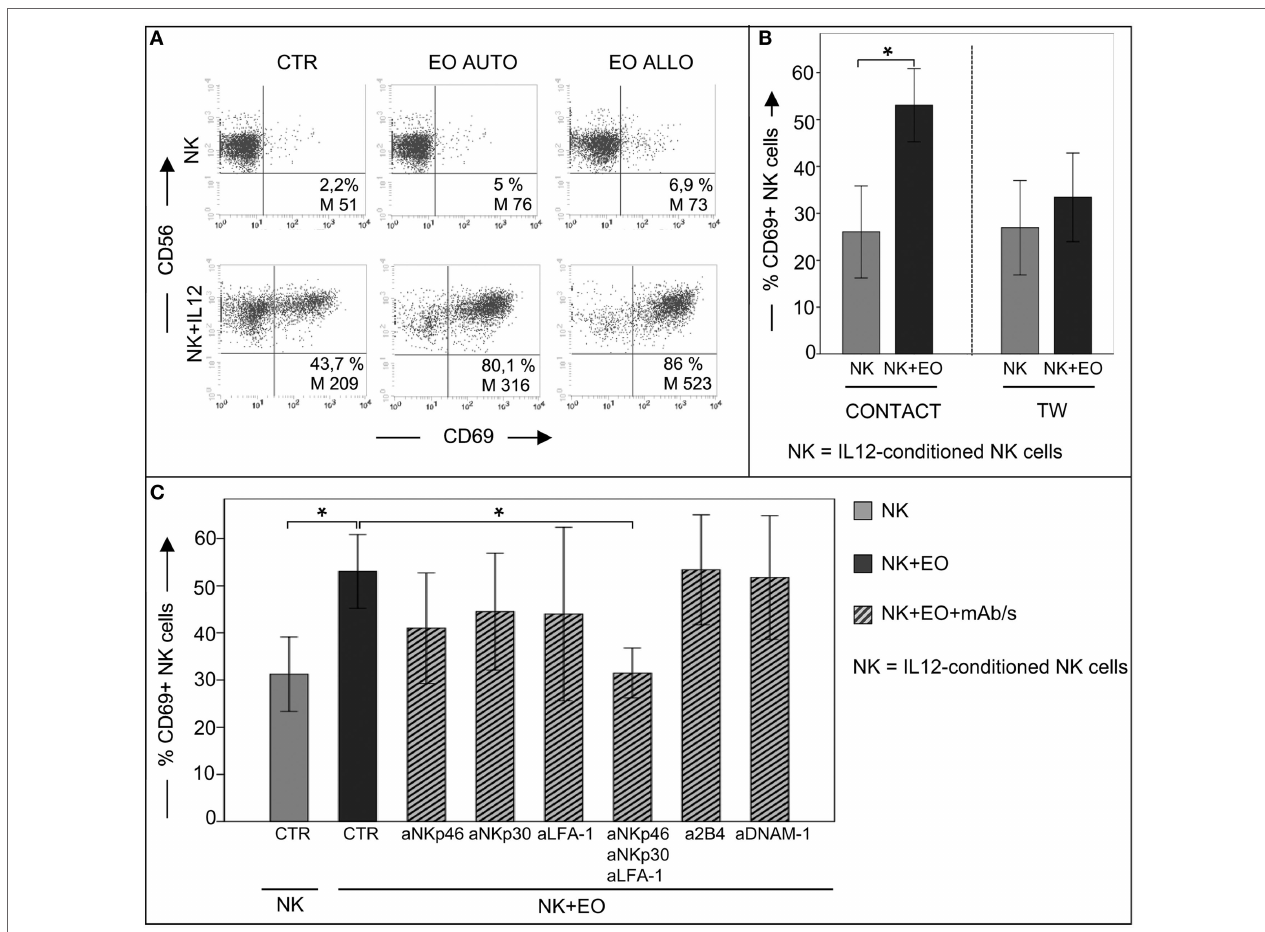
FigUre 2 | analysis of cD69 surface expression on il12-conditioned nK cells after coculture with eosinophils (eOs) freshly purified from healthy non-atopic donors . (a) Resting NK cells or IL12-conditioned NK cells were cultured o.n. with either autologous (AUTO) or allogeneic (ALLO) EOs and then tested for CD69 expression. The NK/EOs ratio in the coculture was of 1 to 1. Surface expression of CD69 on NK cells was analyzed by gating on CD56 + /CD3 − cells. The percentage and median value of CD69 + NK cells are shown for one representative donor out of 10 analyzed. (B) IL12-conditioned NK cells were cocultured with allogeneic EOs, either in the presence of cell-to-cell contact (left) or in transwell (right). After o.n. incubation, NK cells were harvested and analyzed for CD69 expression. Gray bars represent CD69 expression on NK cells cultured alone; black bars refer to CD69 expression on NK cells cocultured with EOs. The NK/EOs ratio in the coculture was of 1:1. The average of six independent experiments is shown (% ± SD). * P < 0.05. (c) IL12-conditioned NK cells were cocultured with EOs in the absence or in the presence of the indicated blocking mAbs; after o.n., NK cells were harvested and analyzed for CD69 expression. Gray bar represents CD69 expression on NK cells cultured alone, black bar refers to CD69 expression on NK cells cocultured with EOs, ribbed bars represent CD69 expression on NK cells cocultured with EOs in the presence of the indicated blocking mAbs. NK/EOs ratio in the coculture was of 1:1. The average of six independent experiments is shown (% ± SD). * P <